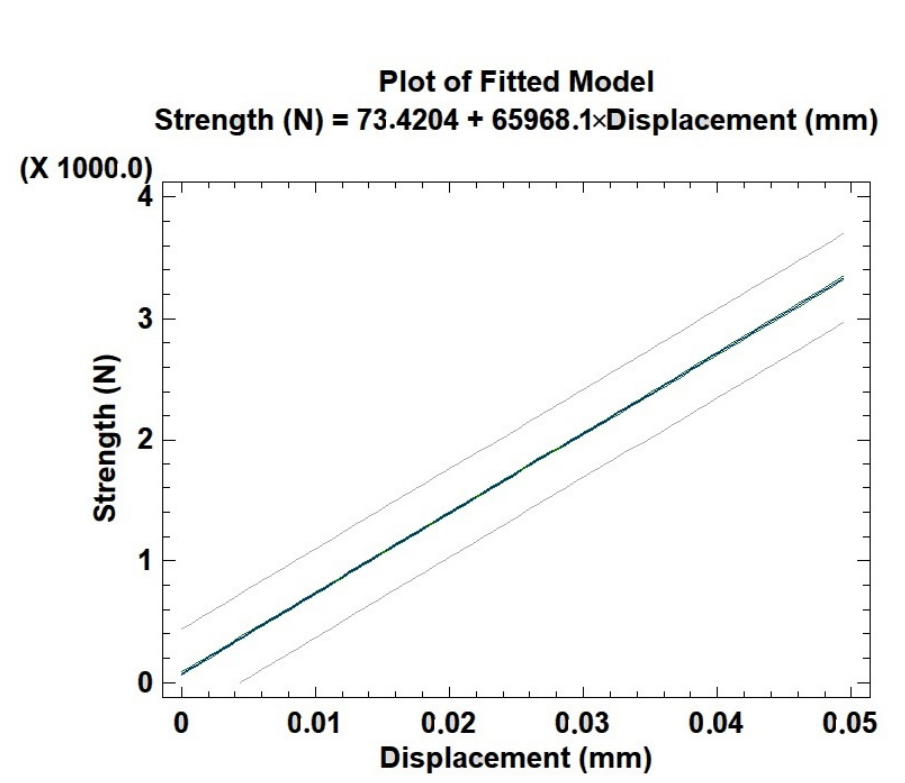
Figure 11. Graph of the adjusted model Test 3. Composite material 50% fly ash (D: 20 mm/E: 70 mm).